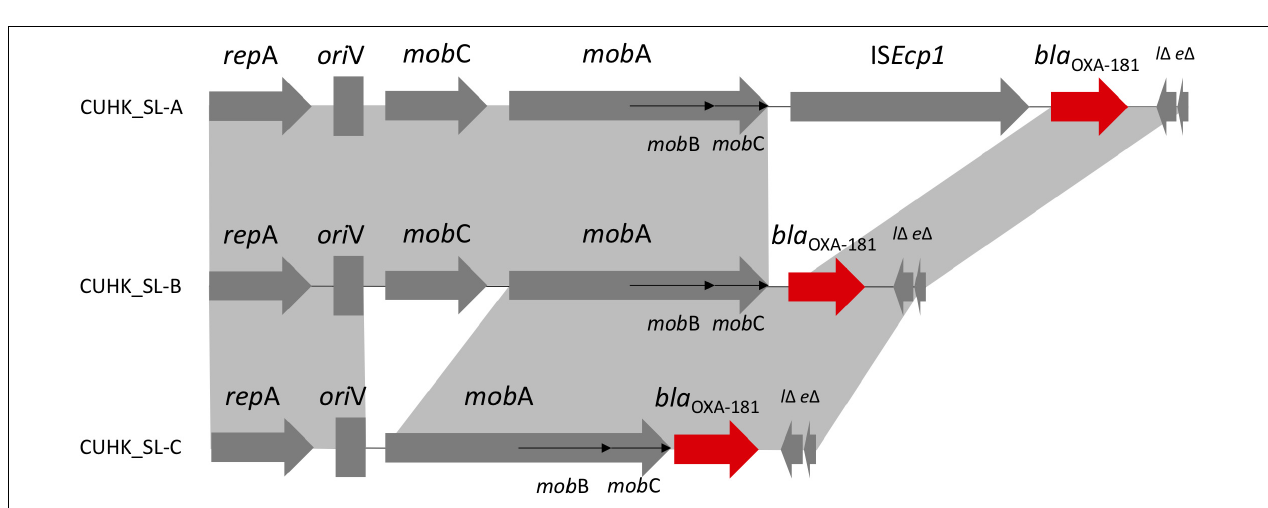
FIGURE 1 | Pan-genome dendrogram of 10 Sri Lanka strains with annotation. ∗ Red boxes indicate presence and yellow for absence.